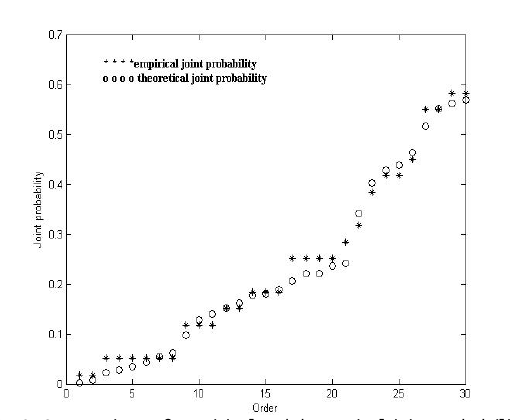
Fig. 3. Comparison of empirical and theoretical joint probability of the AMFOD and AMFM of Huayuankou station